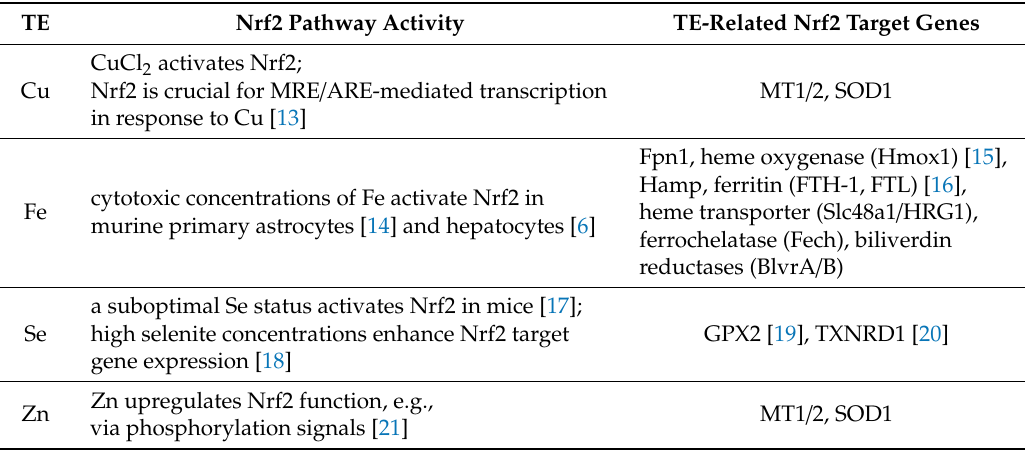
Table 1. E ff ects of single trace elements on Nrf2 signaling (overview in